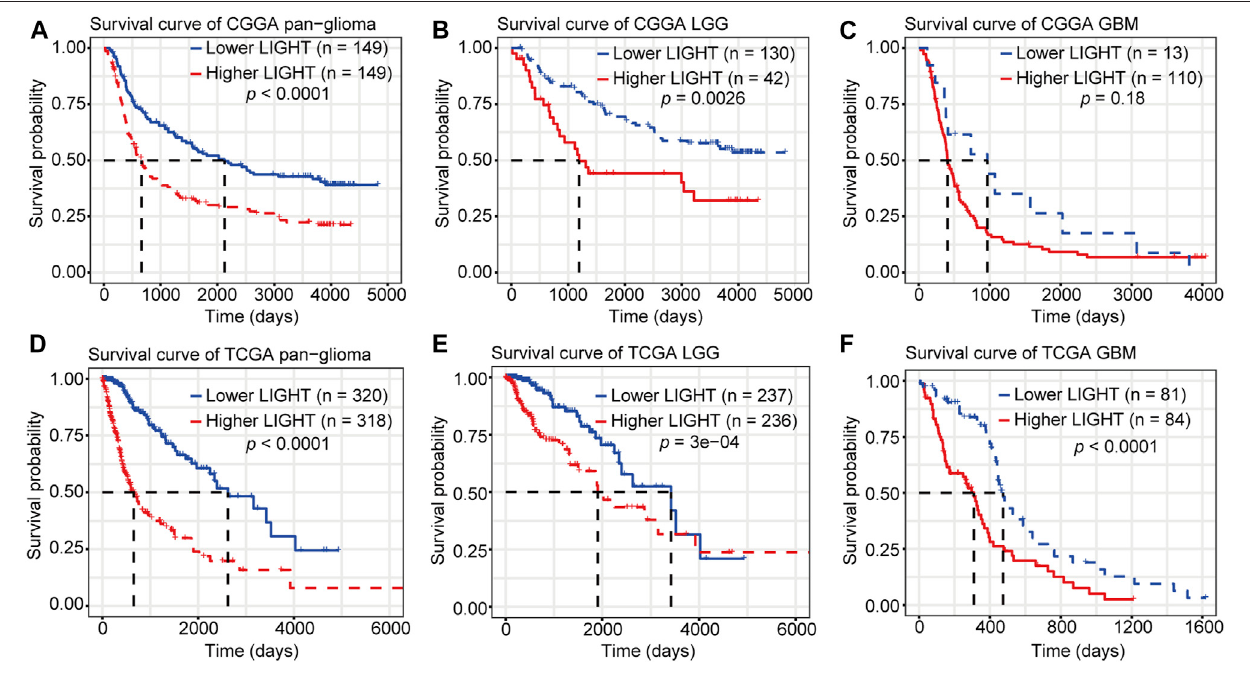
FIGURE 5 | Survival analysis for LIGHT in pan-glioma (A , D) , LGG (B , E) , and GBM (C , F) .